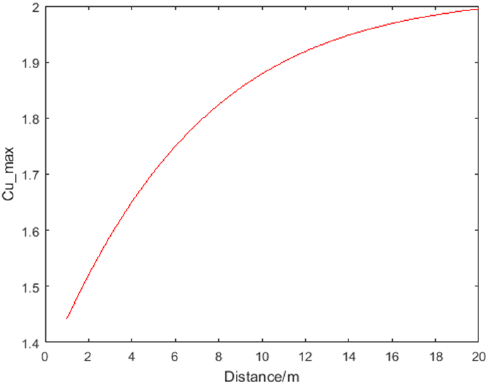
Figure 5. (cid:1829) (cid:3048)_(cid:3040)(cid:3028)(cid:3051) for d within 20 m and σ = 0.1 m. Figure 5. C u _ max for d within 20 m and σ = 0.1